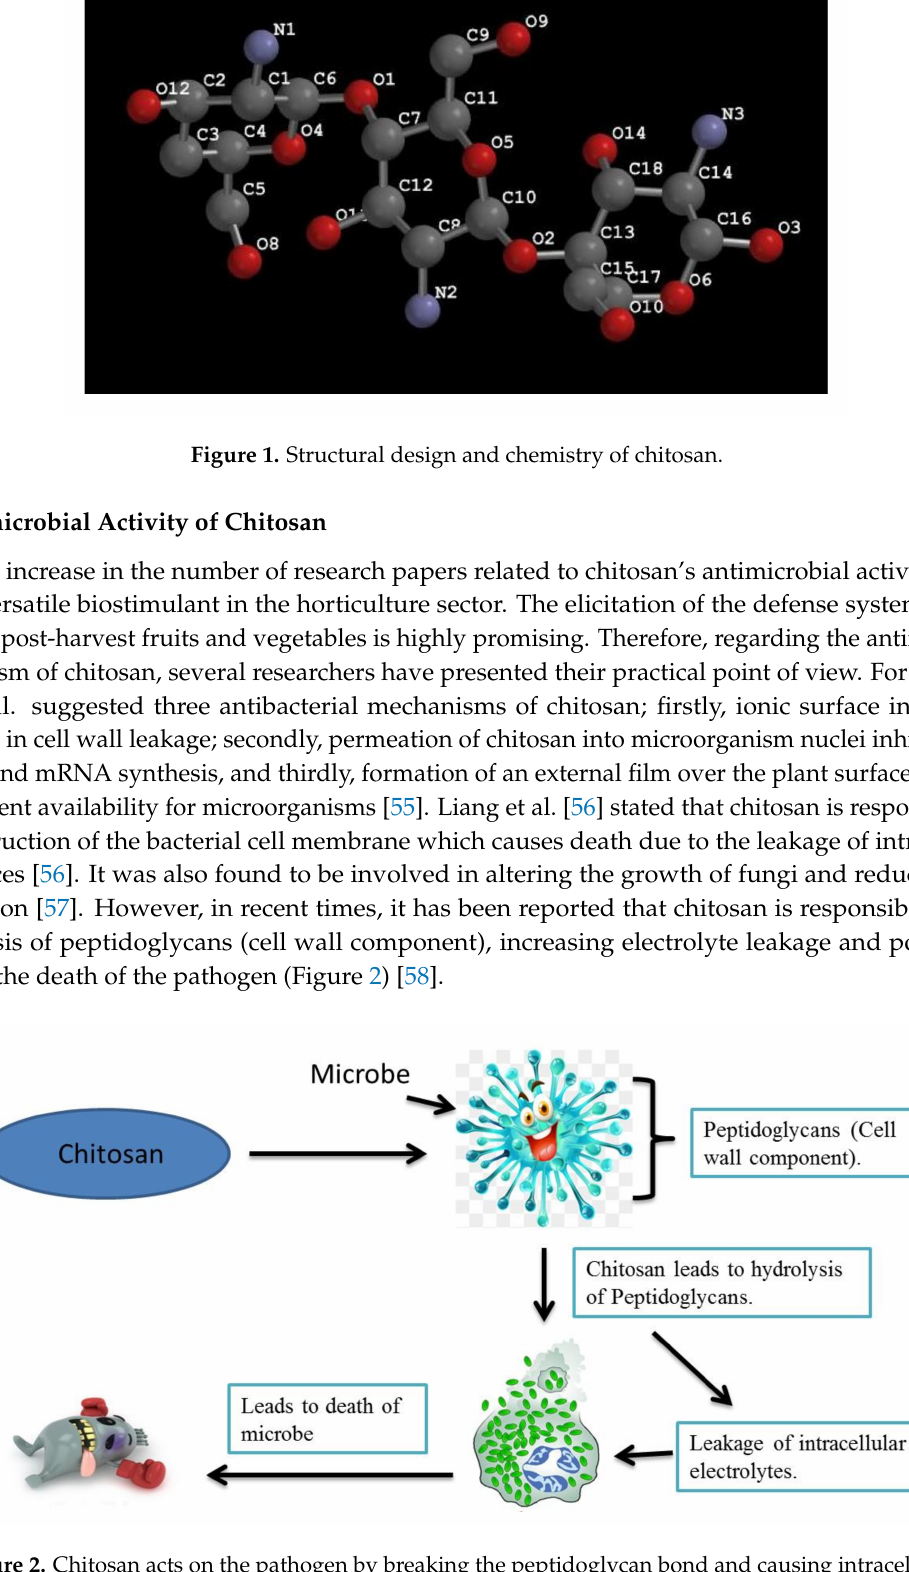
Figure 2. Chitosan acts on the pathogen by breaking the peptidoglycan bond and causing intracellular electrolyte leakage which leads to the death of the